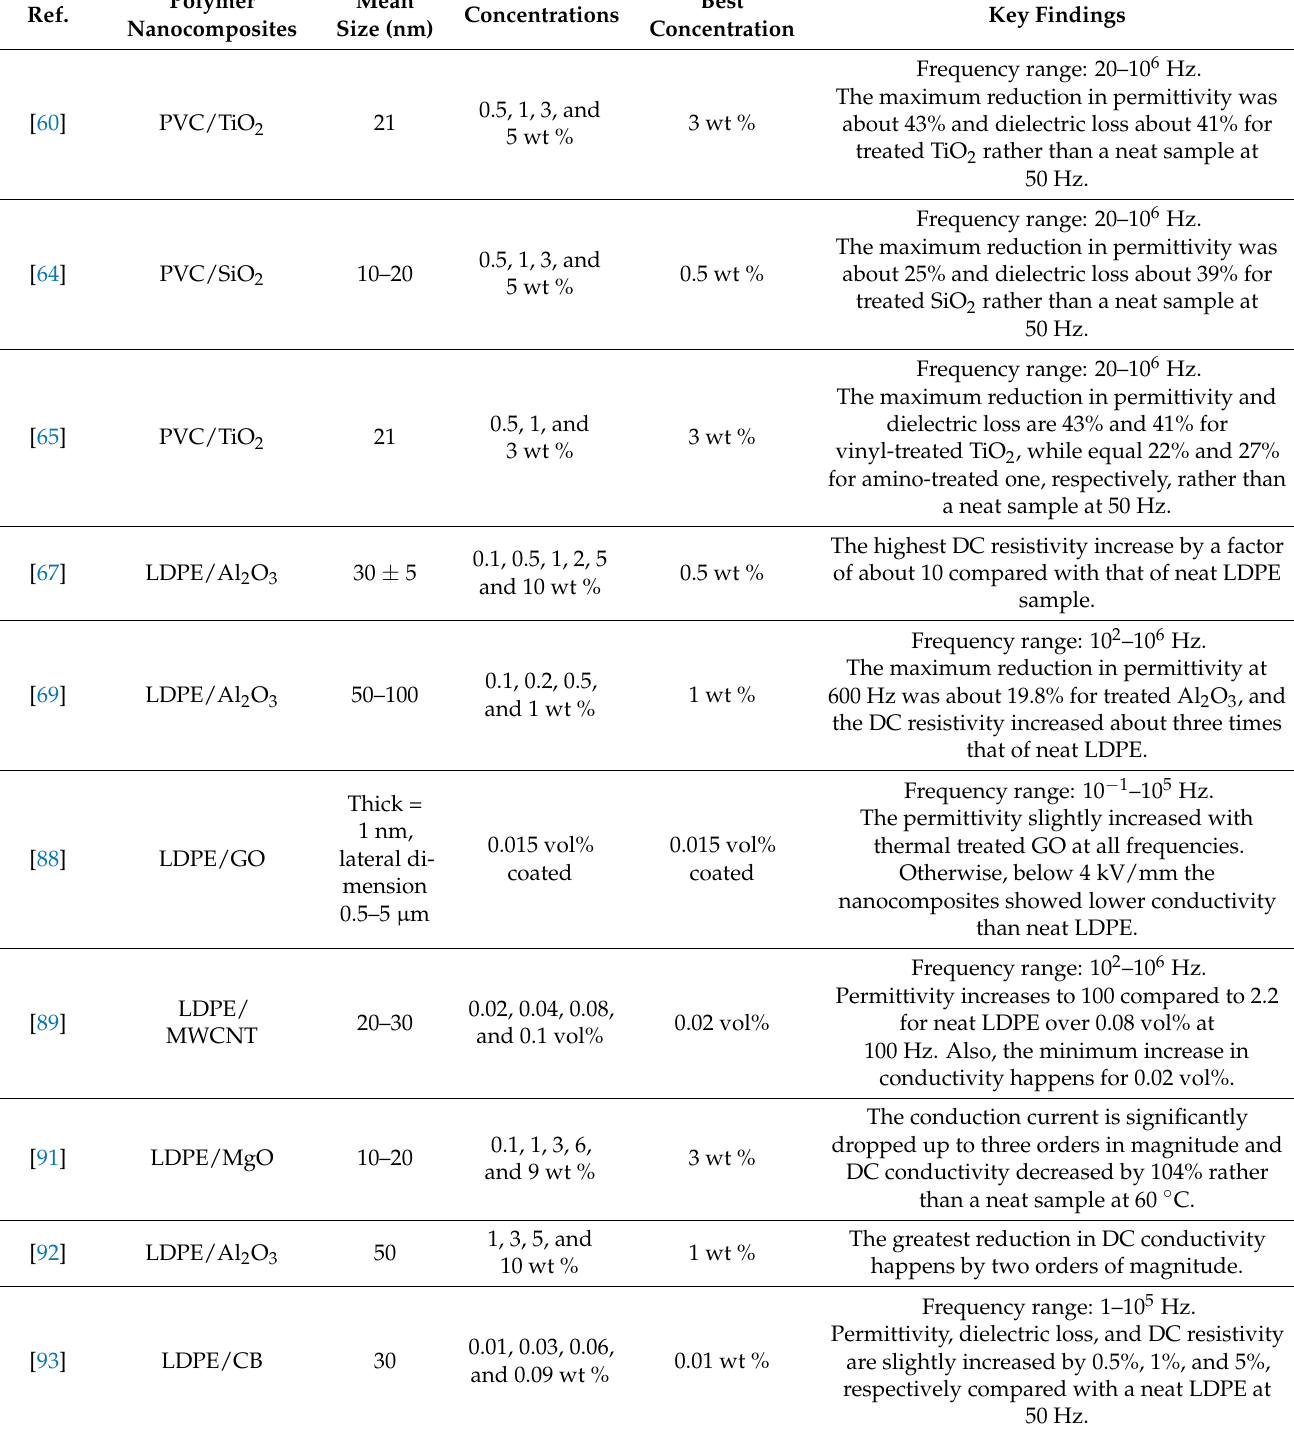
Table 4. Dielectric properties of polymer nanocomposites based on PE and PVC.